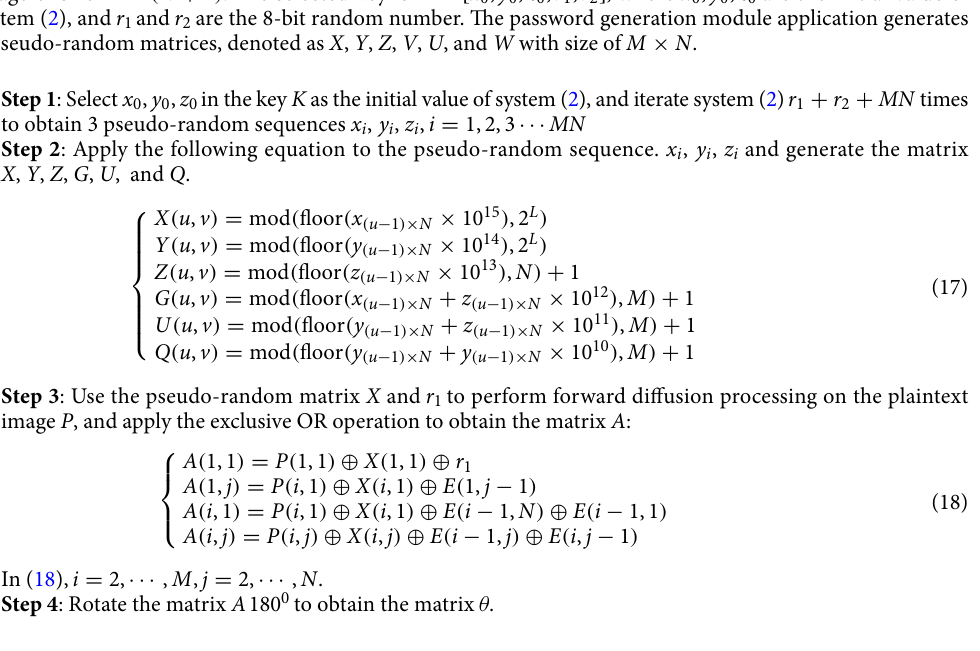
x 3 plane at various times. ( a ) When − i k ( 3 ) = ( 3 ) = 2 , the circuit simulation diagram of the x 3 −